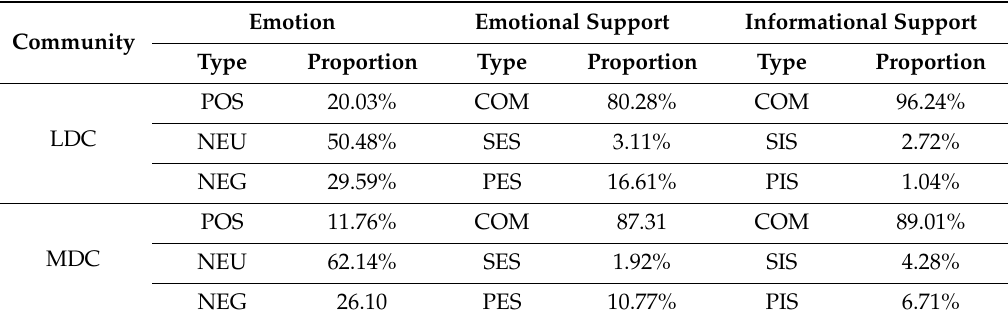
Table 1. Proportion of postings of each type in the annotated dataset of the management depression community (MDC) and lacking-management depression community (LDC).